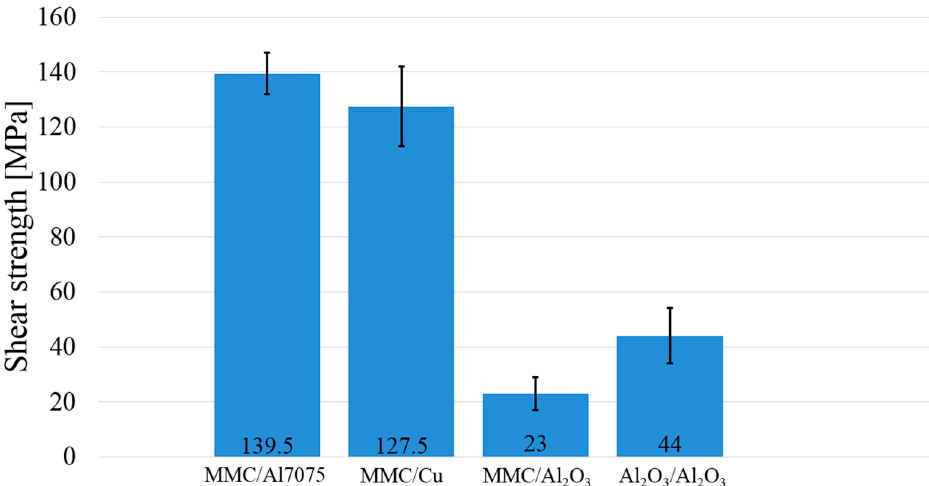
Figure 14. Measurement of shear strength of the joints fabricated with Zn6Al6Ag solder.